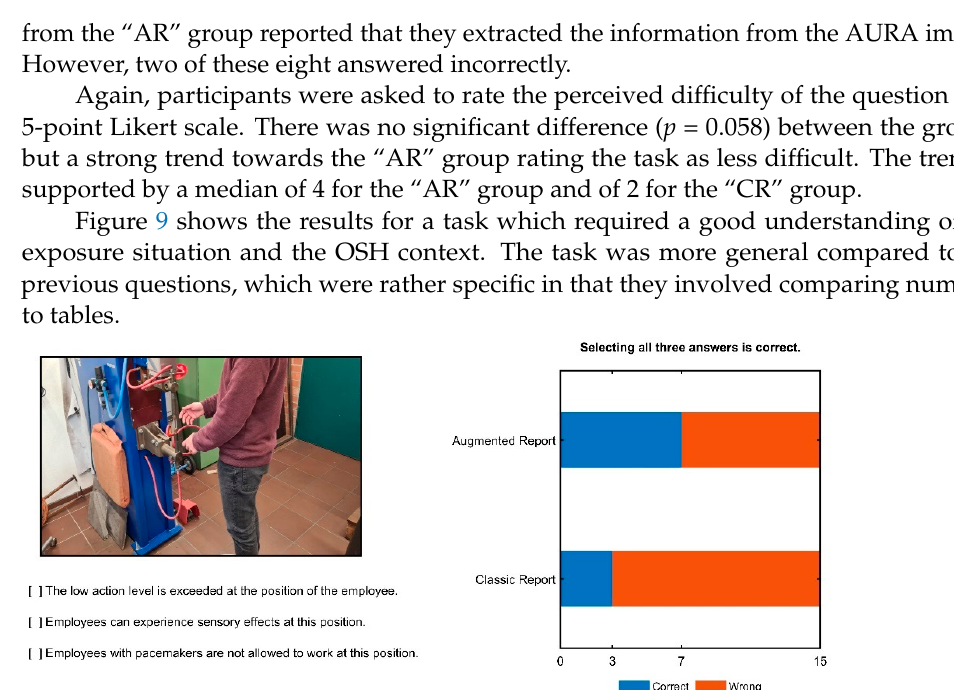
Figure 9. Three statements about the work position could be selected, and selecting all three correct statements equaled a correct response. This task required a good understanding of the exposure situation and the OSH context and therefore, was relatively difficult. In line with the other results, the “AR” group performed better.